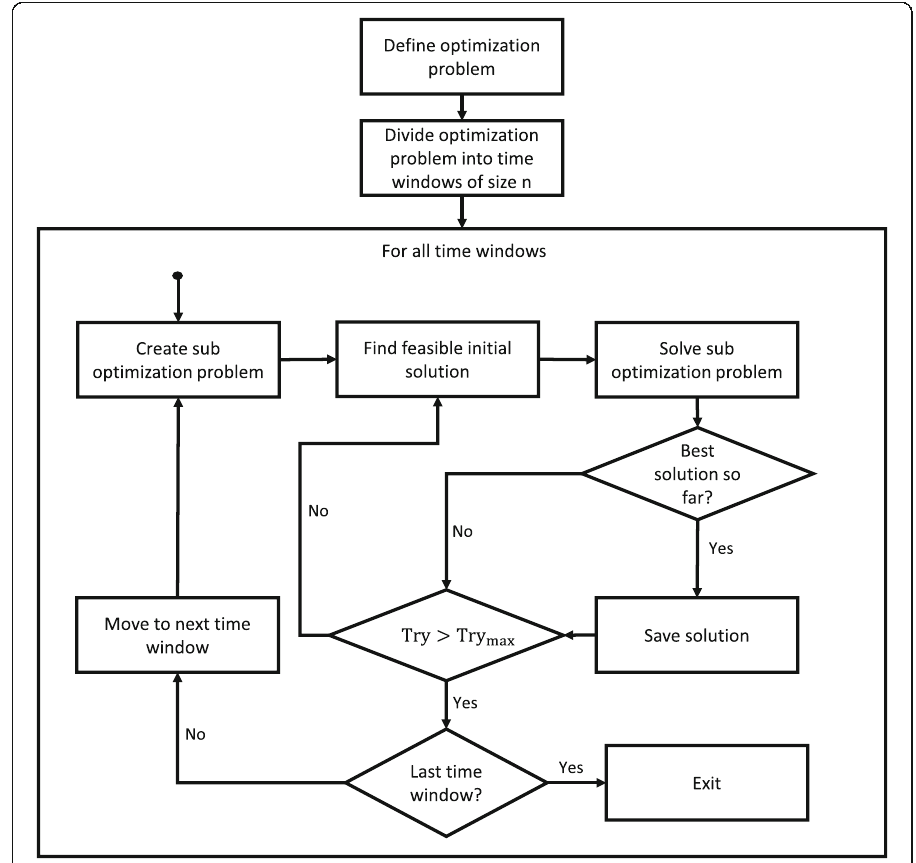
Fig. 3 Flowchart of the optimization